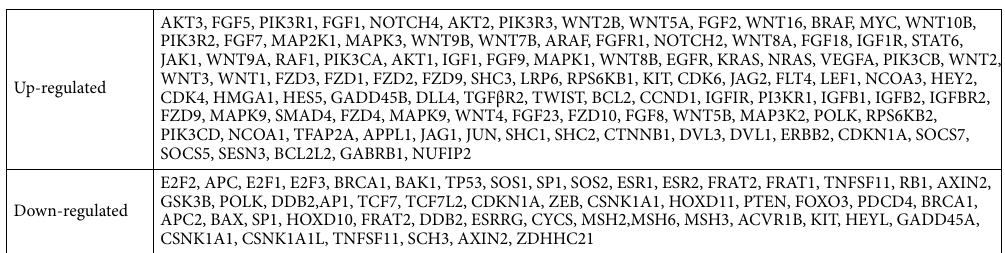
Table 3. The predicted candidate genes in breast cancer patients.